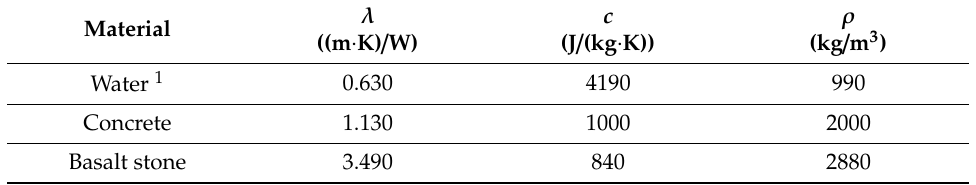
Table 4. Thermal conductivity ( λ ), specific heat ( c ), and density ( ρ ) of thermal storage materials evaluated